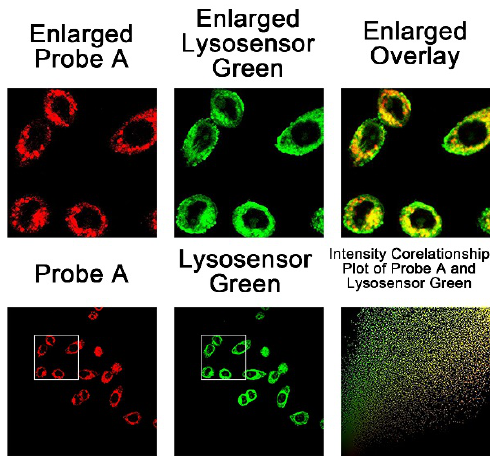
Figure 13. Enlarged confocal fluorescence images of HeLa cells incubated with probe A and Lysosensor Green in pH 3.50 buffer containing 10 µM nigericine from Figure 12.